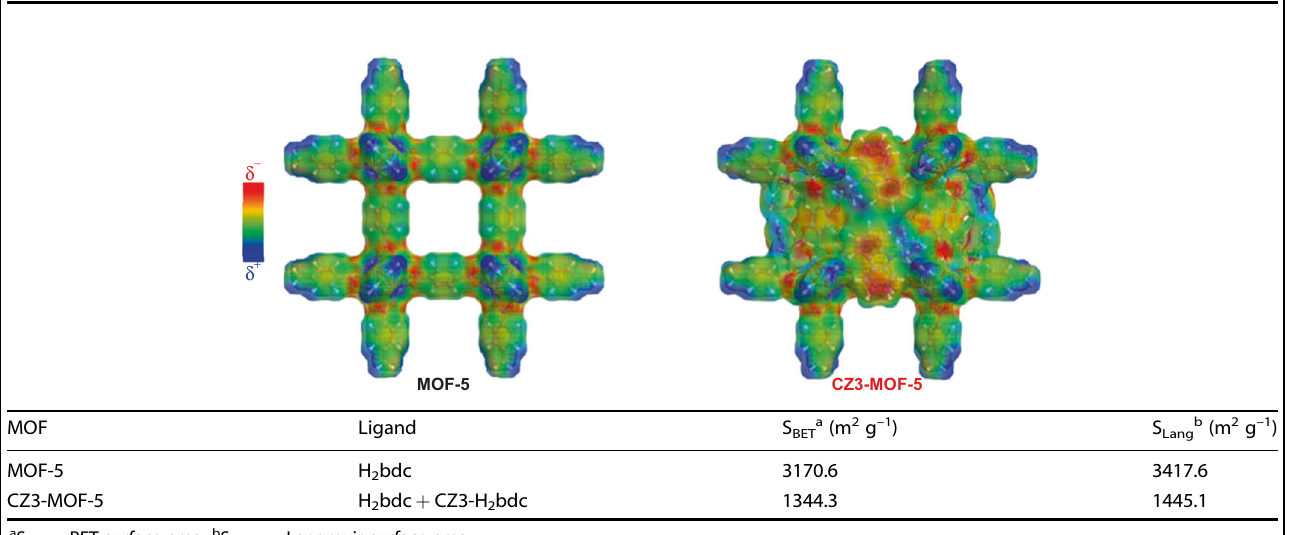
Table 1. Electrostatic potential (ESP) maps and speci fi c surface areas of MOF-5 and CZ3-MOF-5.